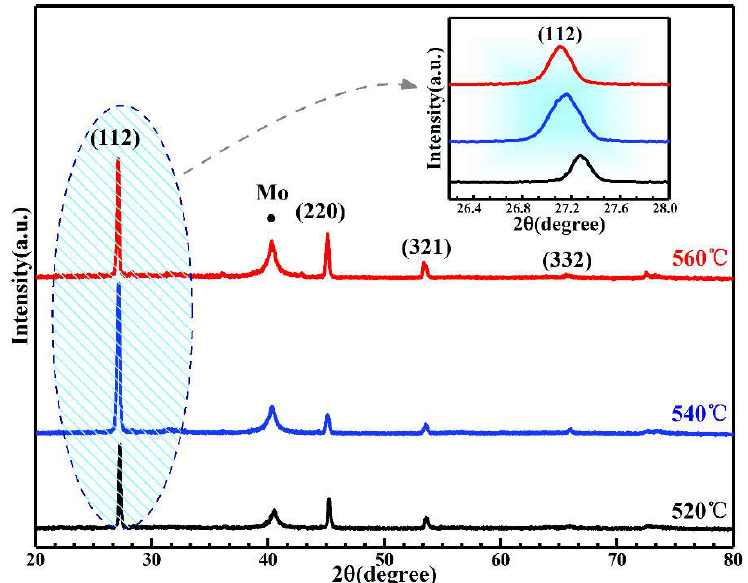
Figure 1. XRD patterns of Na-doped Cu 2 ZnSn(S,Se) 4 films selenized at different temperatures. Inset: enlarged spectra of (112) diffraction peaks.